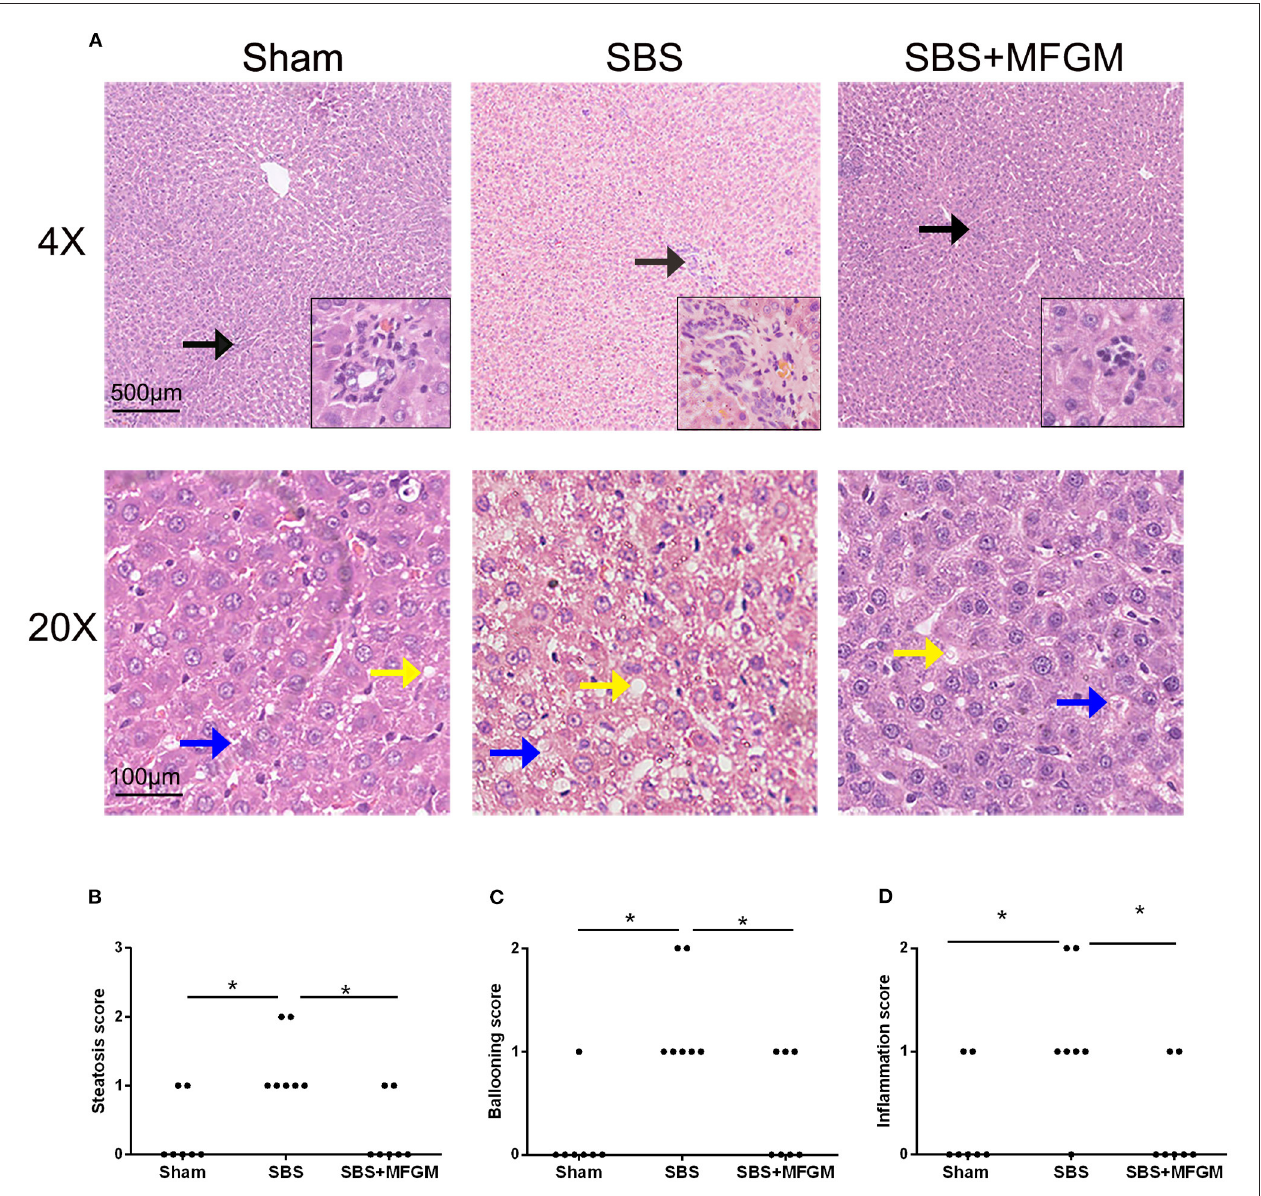
FIGURE 1 | Liver images by HE-staining (A) and comparison of the liver histology scores in steatosis, ballooning, and inflammation (B–D) . The upper panels show a low-power view ( × 4), scale bar: 500 µ m. The lower panels show a high-power view ( × 20), scale bar: 100 µ m. Liver lesion inflammation (black arrow), steatosis (yellow arrow), and ballooning (blue arrow). Group differences were determined by Kruskal-Wallis H -test followed by Dunn-Bonferroni post hoc test and * P < 0.05 indicates a difference between the two groups. MFGM, milk fat globule membrane; SBS, short bowel